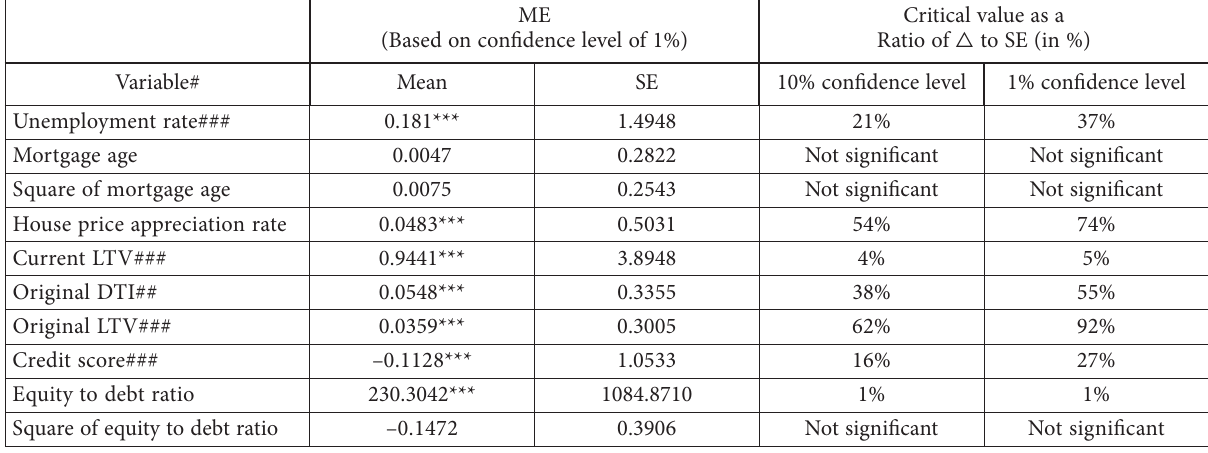
Table 5. ME of RF